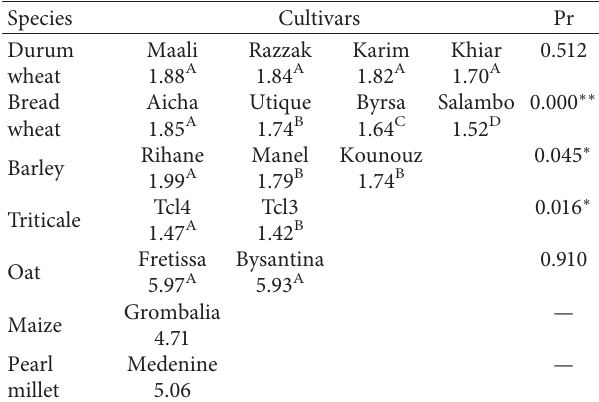
Table 1: Cereal species and varieties used in the present study. Species Varieties Durum wheat ( Triticum durum Desf . )